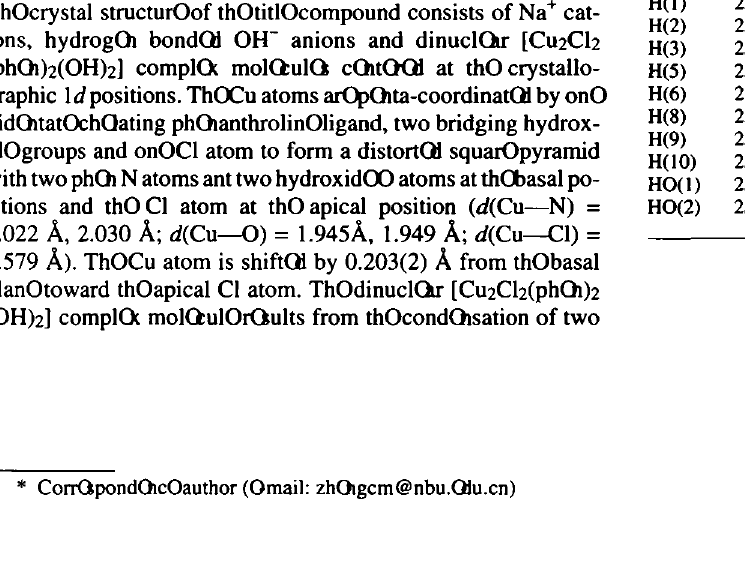
Table 2. Atomic coordinatQ and displacOnCht paramQOs (in A 2